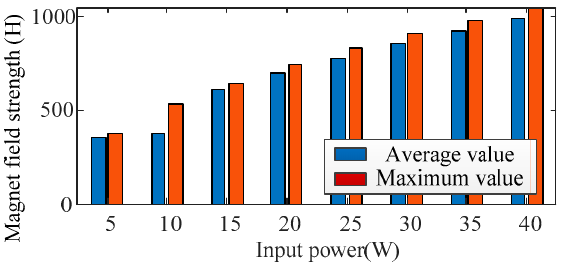
Figure 13. Maximum and average values of magnetic field strength due to the fringe effect with different input powers.